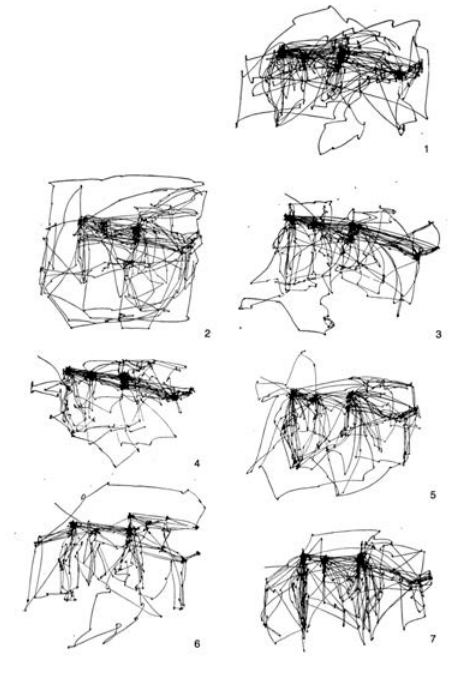
Figure 14. Yarbus shows the eye fixation tracks for seven individual subjects, each viewing the scene for 3 minutes without any instruction. (From Yarbus 1967)